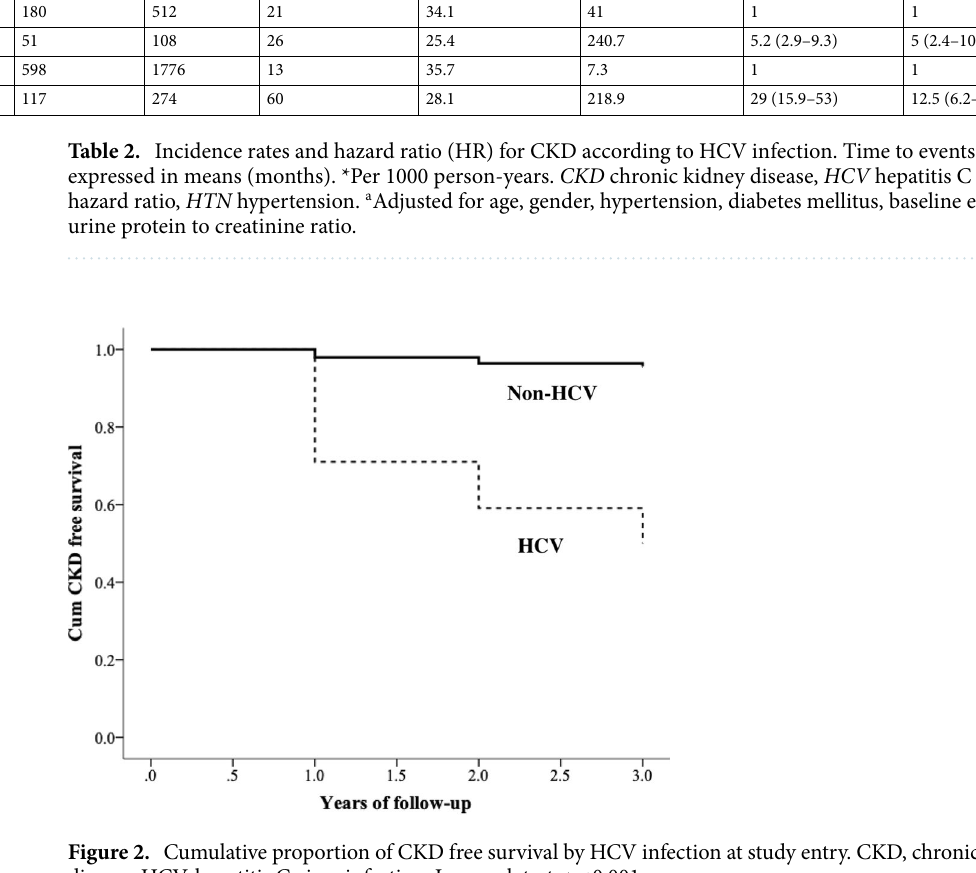
Figure 2. Cumulative proportion of CKD free survival by HCV infection at study entry. CKD, chronic kidney disease; HCV, hepatitis C virus infection. Log-rank test, p <